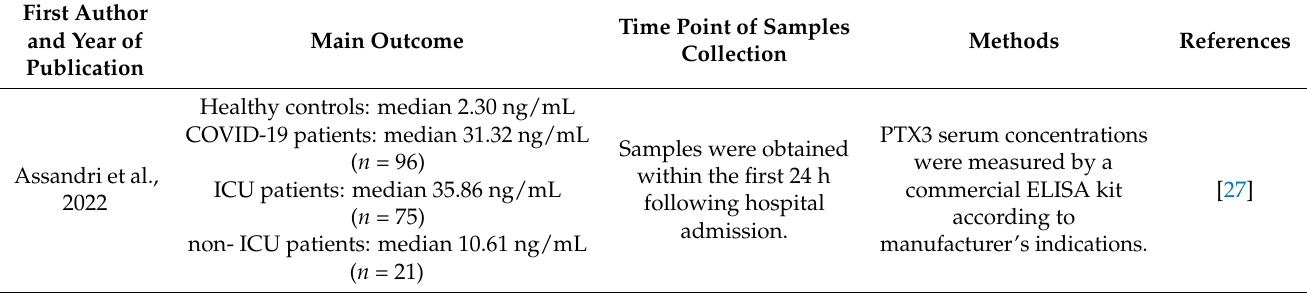
Table 3. Table summarizing the articles included in the systematic review and related PTX3 levels in different subjects.